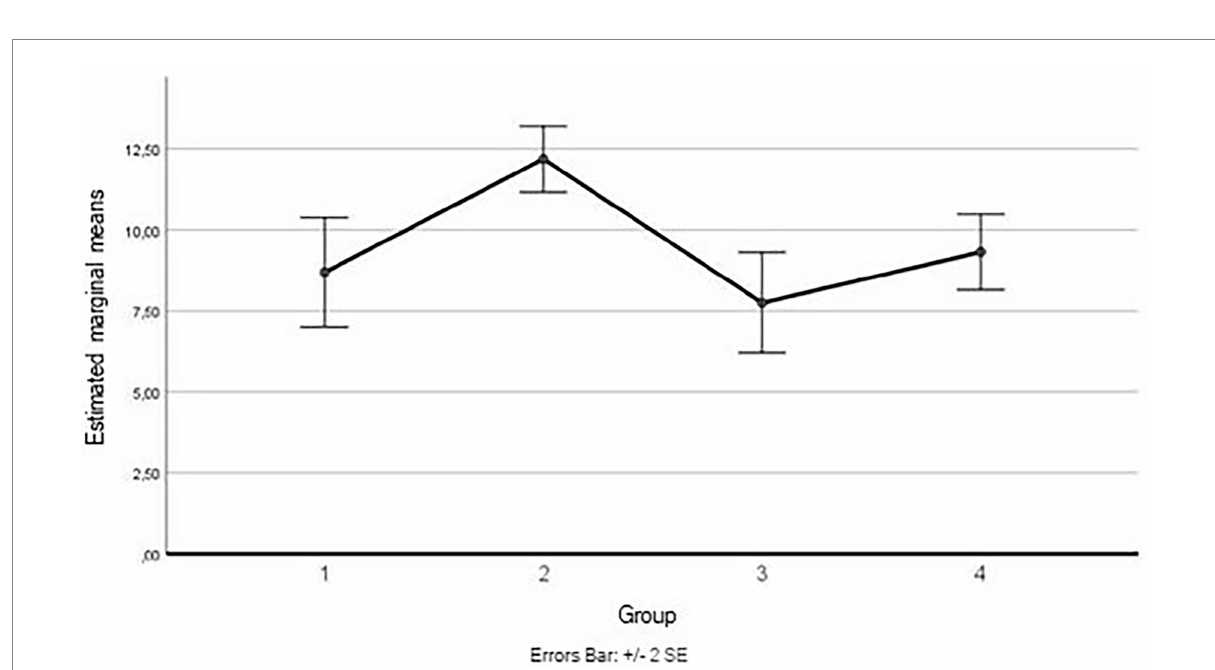
FIGURE 6 Estimated marginal means for the fear of medical pain (after the vision of